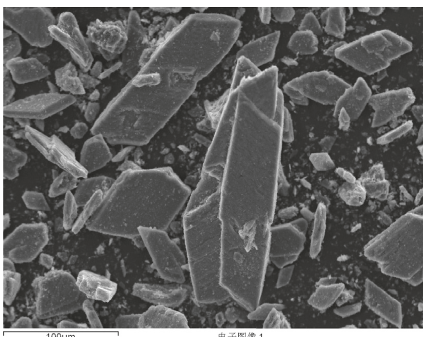
Figure 1: SEM photo of phosphogypsum (ruler 100 μ m).